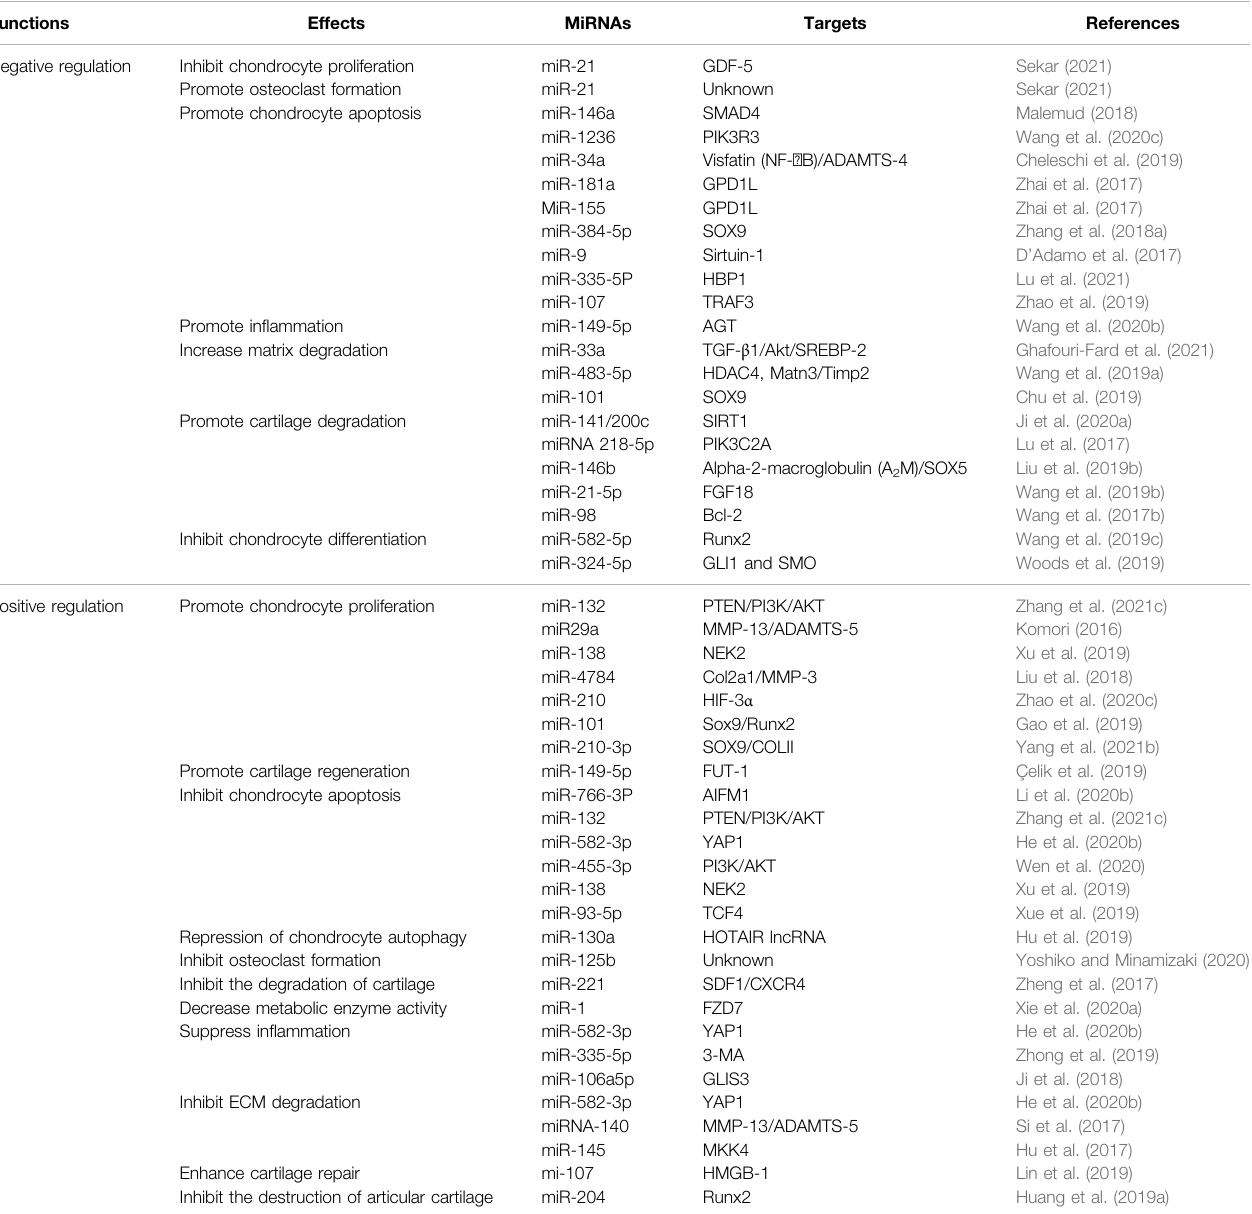
TABLE 1 | miRNA and the targets in